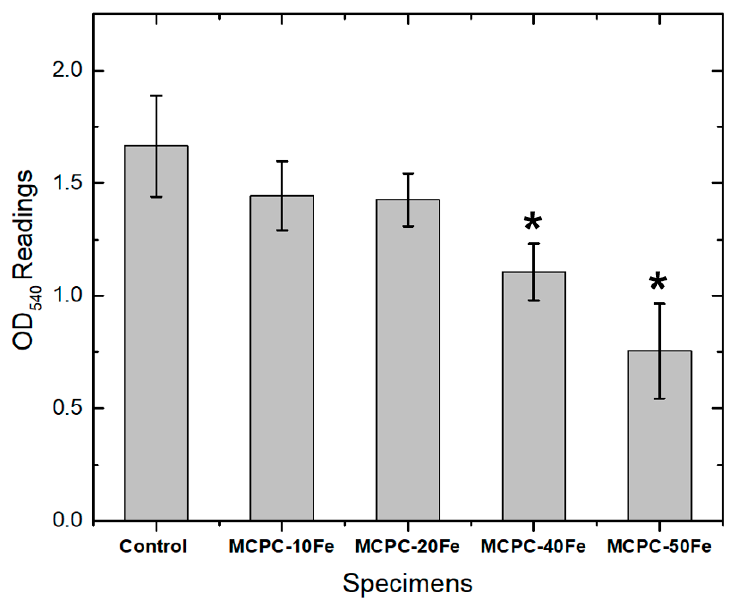
Figure 4. OD 540 readings indicating the cell viability results of MC3T3 pre-osteoblasts cultured on MCPC with different concentrations of magnetite. MCPC indicates magnetic calcium phosphate cement, and Fe indicates magnetite incorporation.